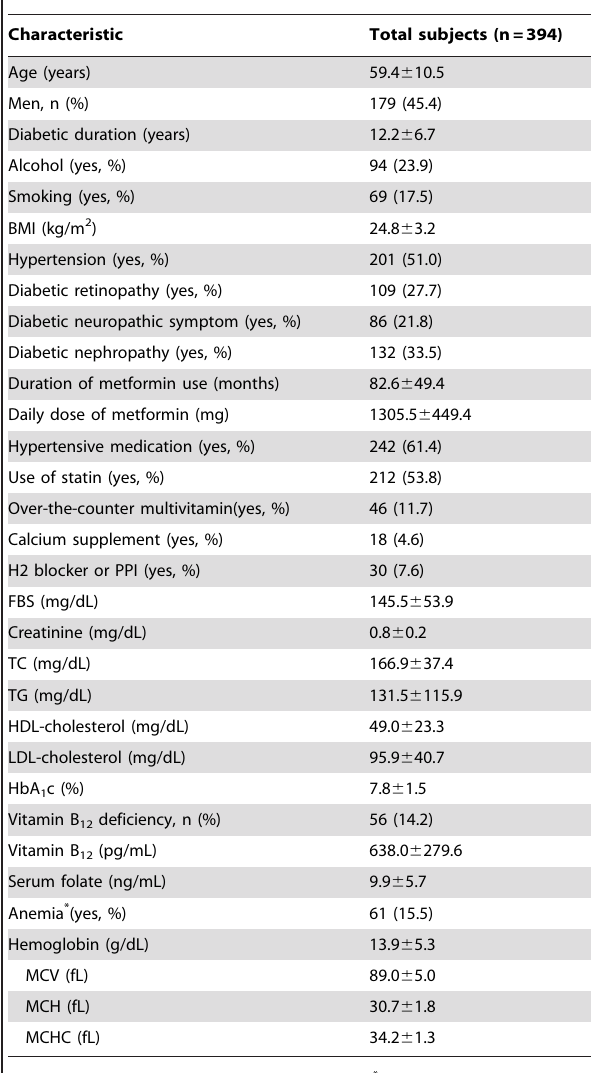
Table 1. Baseline clinical characteristics of the